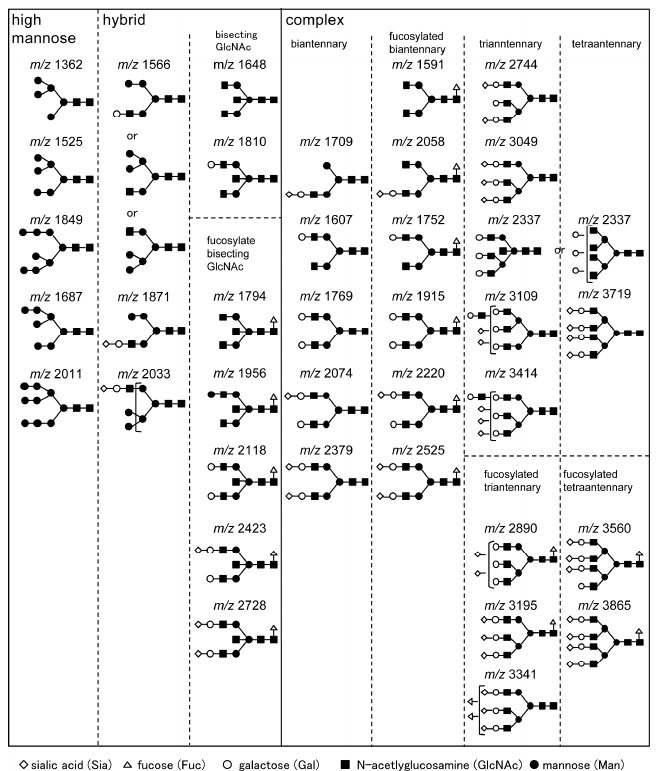
Figure 1. Schematic representation of 36 types of N -glycans identified by N -glycomics. Putative structures of N -glycans are presented by means of monosaccharide symbols. Clear circles, galactose (Gal); black circles, mannose (Man); black squares, N -acetylglucosamine (GlcNAc); clear triangles, fucose (Fuc); and clear diamonds, N -acetylneuraminic acid (sialic acid). m / z represent mass divided by charge number and horizontal axis in a mass spectrum is expressed in units of m / z .